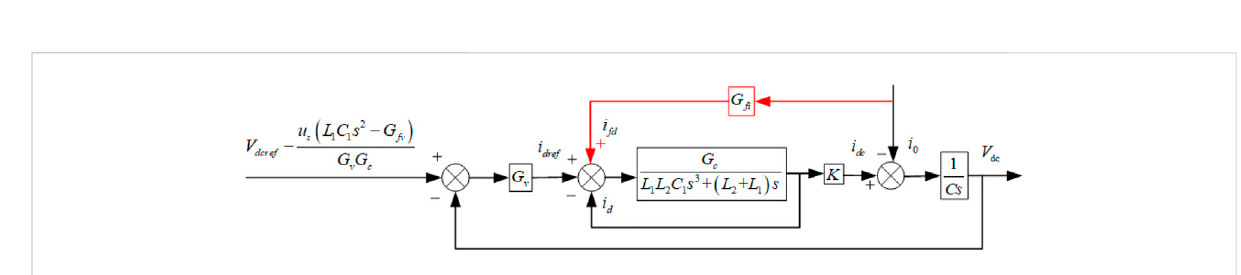
FIGURE 6 Simpli fi ed double closed-loop control block diagram with the addition of feedforward